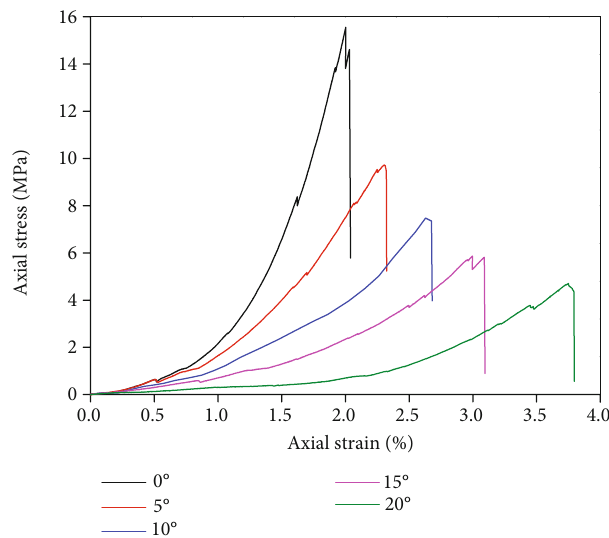
Figure 7: Stress-strain curves of coal specimens under various inclination